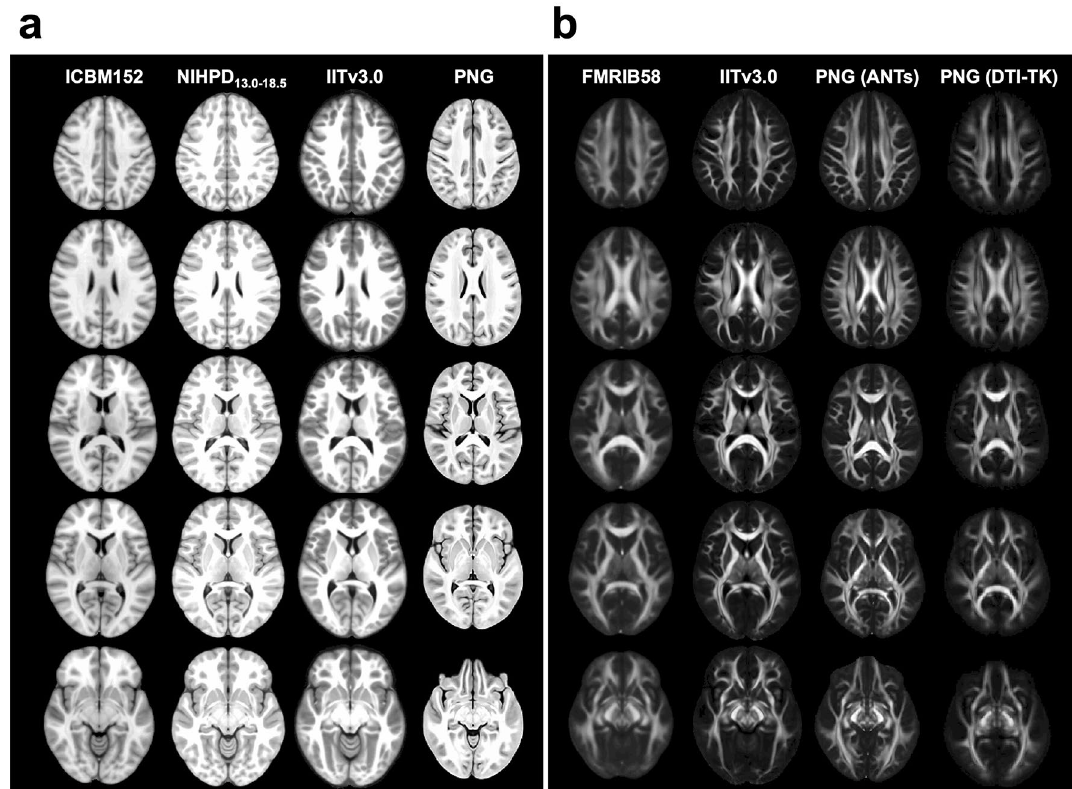
Figure 1. Visual illustration of the differences in shape and size between the standardized and population- specific templates, including ( a ) the standardized ICBM152 (ages 18.5–43.5) 9 , NIHPD 13.0–18.5 21 , IITv3.0 11 , and PNG T1 templates; ( b ) the standardized FMRIB58 (FMRIB, Oxford, UK), IITv3.0 11 , and PNG DTI templates constructed by ANTs 57 and DTI-TK 95